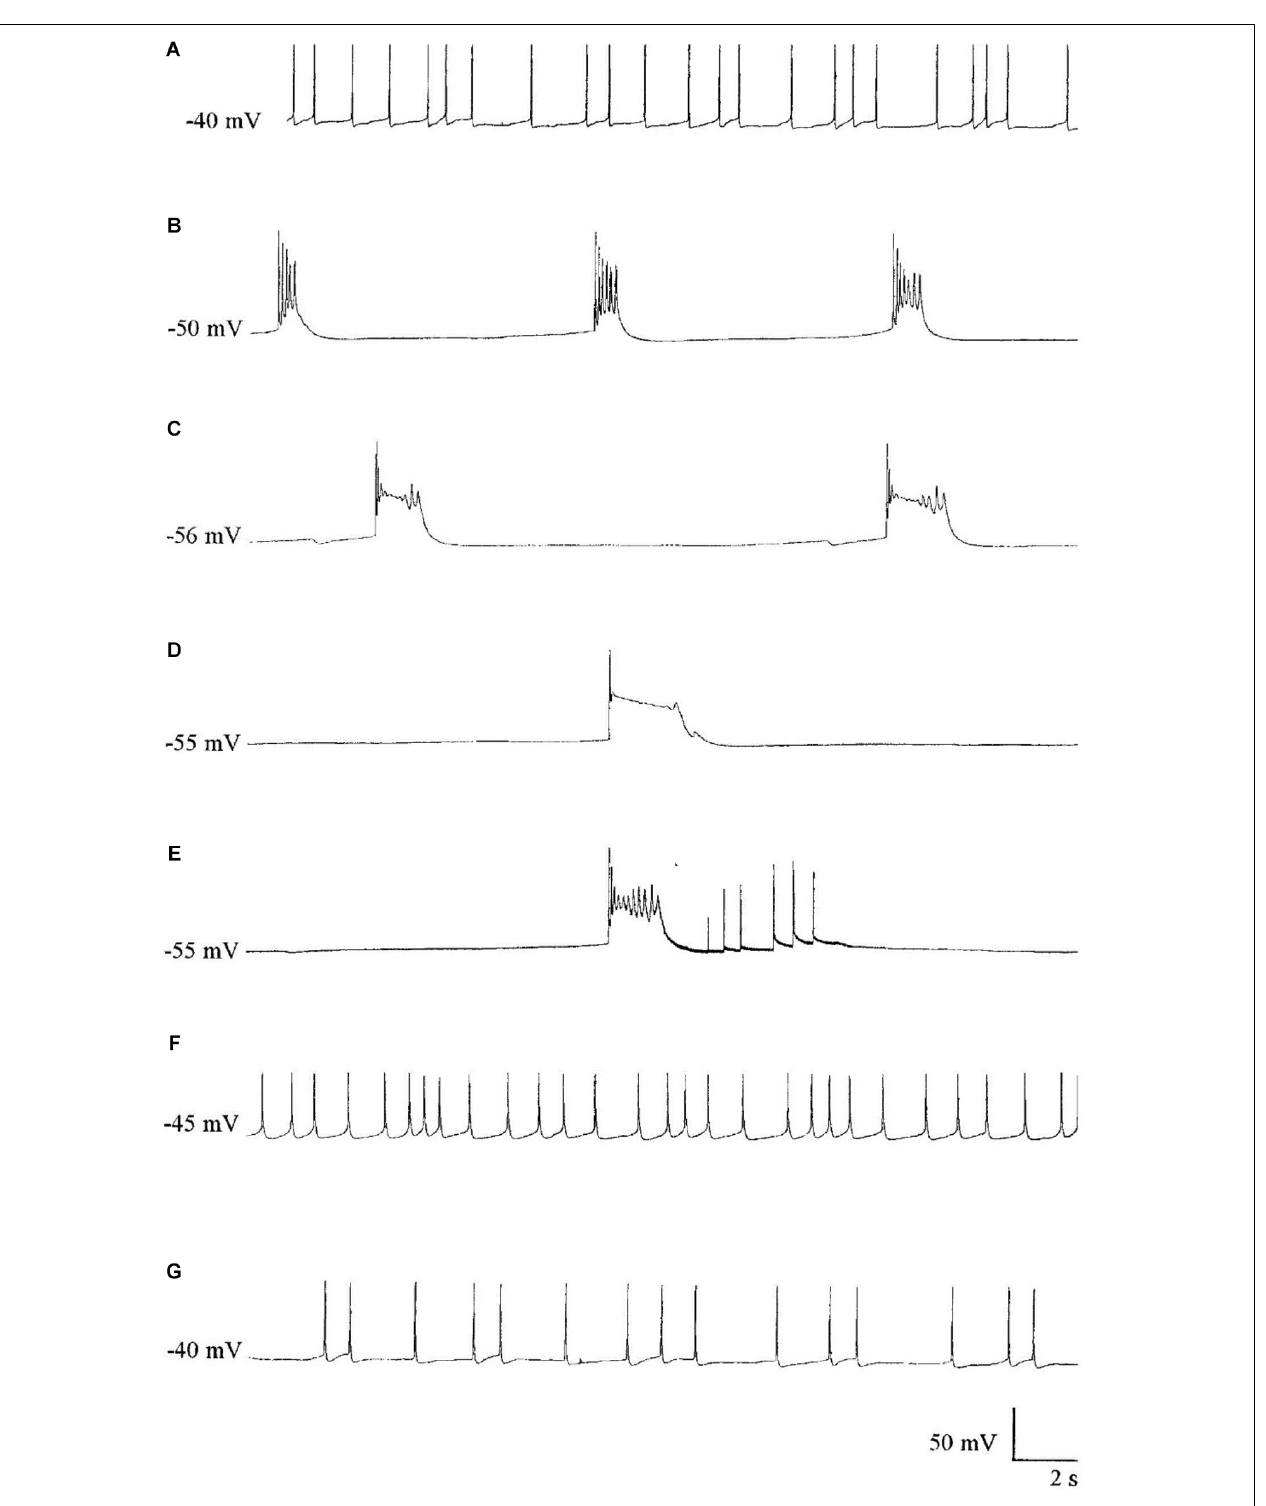
FIGURE 2 | The effect of Pentobarbital on the spontaneous firing pattern and frequency of an A group neuron. (A) control; (B) 1 mM pentobarbital after 6 min; (C) 1 mM pentobarbital after 30 min; (D) 2 mM pentobarbital after 6 min; (E) 10 min wash out prior to quiescence and (F) 30 min wash out and (G) 60 min wash out. Membrane potential increased in response to pentobarbital, and decreased as continuous wash out of pentobarbital proceeded. (From Moghadam, 1996 – Reproduced under the Creative Commons License).